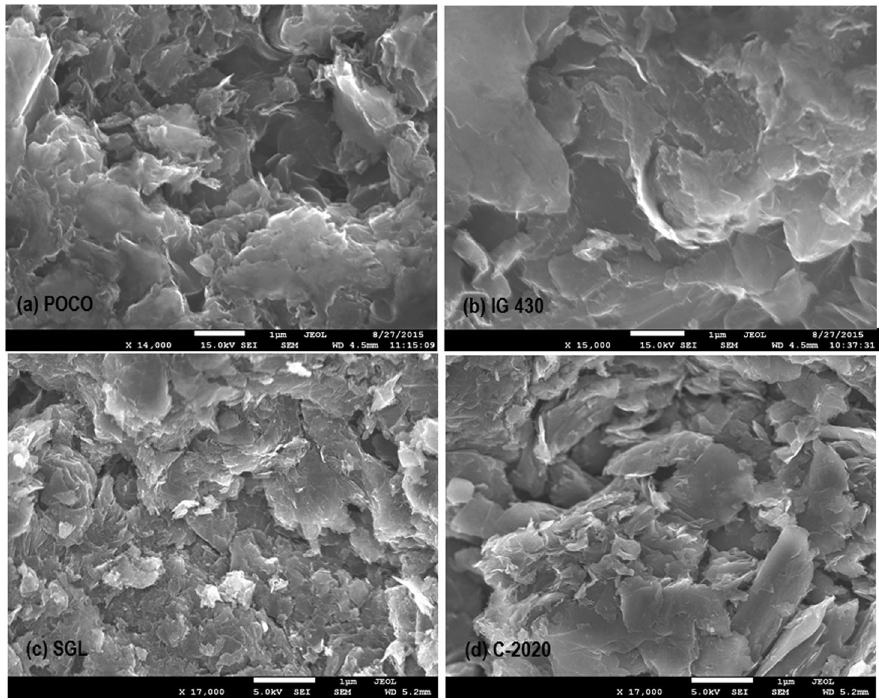
FIG. 1. Microstructural characterization and comparison of the four graphite grades using scanning electron